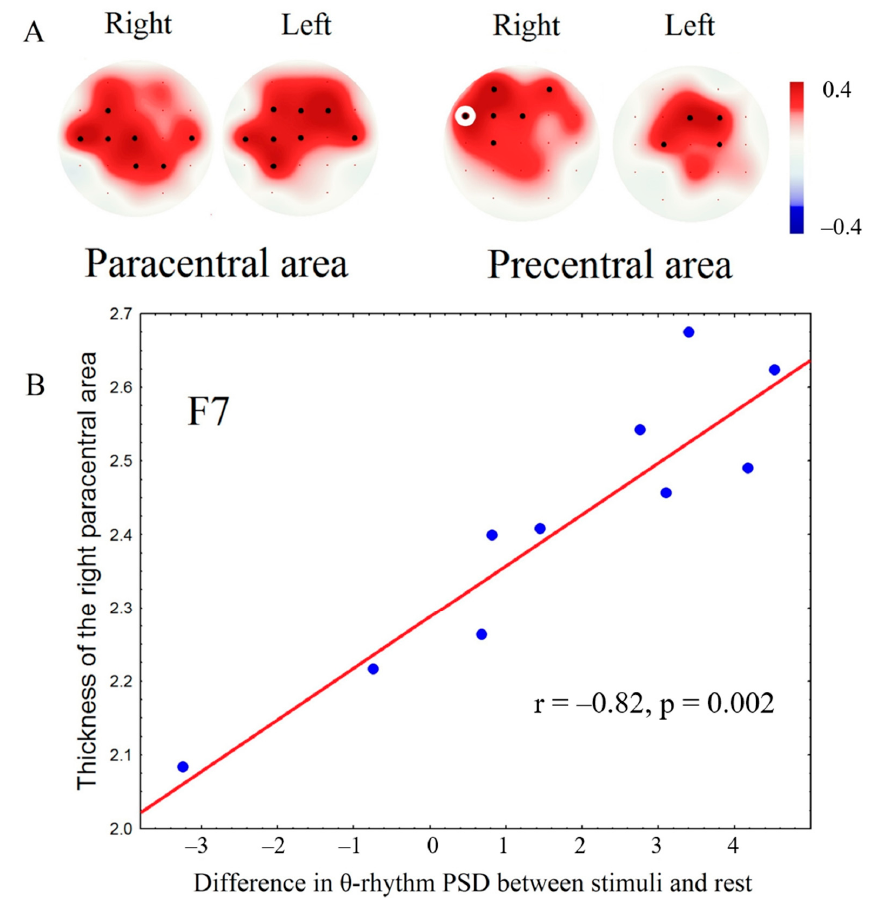
Figure 6. Results of correlation analysis between cortical thickness and averaged increase of beta rhythm power during tactile stimulation compared to the rest. A: maps of significant correlations (black dots—electrodes showing significant correlations after Bonferroni correction); B: scatterplot showing a relation between EEG spectral power at the electrode marked by a white circle and grey matter thickness (x—difference between beta rhythm PSD during tactile stimulation compared to rest, y—cortical thickness in mm), blue dots—individual values.